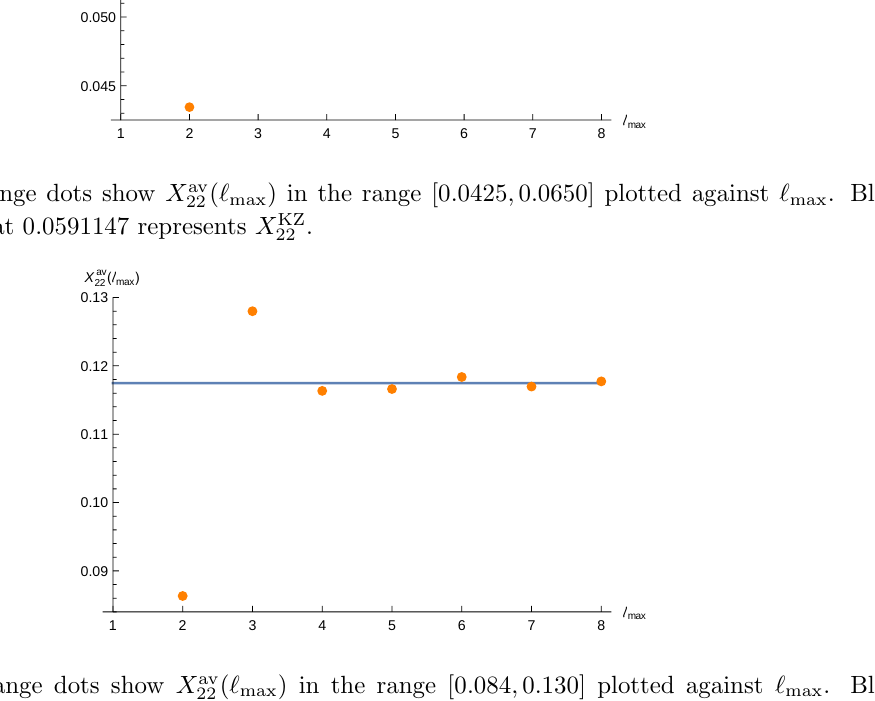
( ‘ max ) in the range [0 : 084 ; 0 : 130] plotted against ‘ max . Blue 22 22